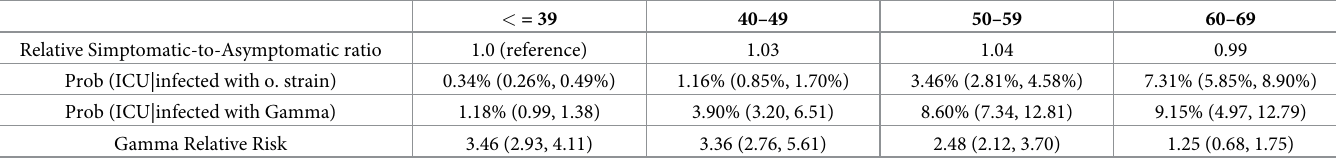
Table 6. Alternative relative risk and probabilities of ICU admission conditional on symptomatic infection (and confidence intervals) by age using age-dependent symptomatic-to-asymptomatic